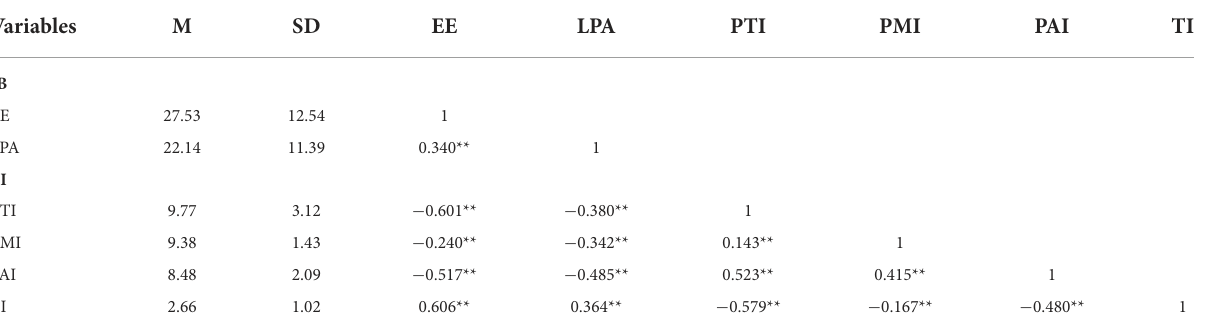
TABLE 4 Correlations among TI, PI, and JB.